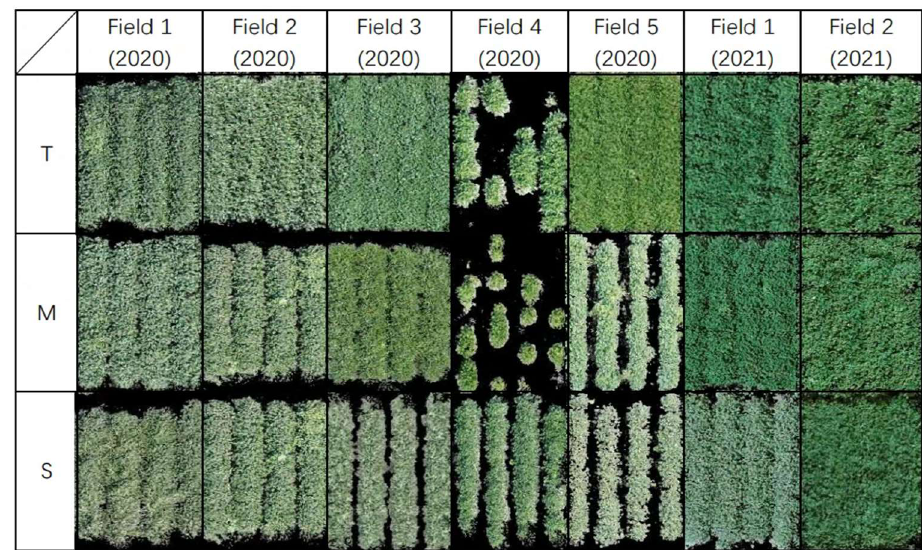
Figure 4. Examples of UAV images of different soybean genotypes at three tolerance classes to off-target dicamba damage. Images were selected from genotypes in different fields in different years to illustrate the variation in plant characteristics. T: tolerant, M: moderate, S: susceptible.